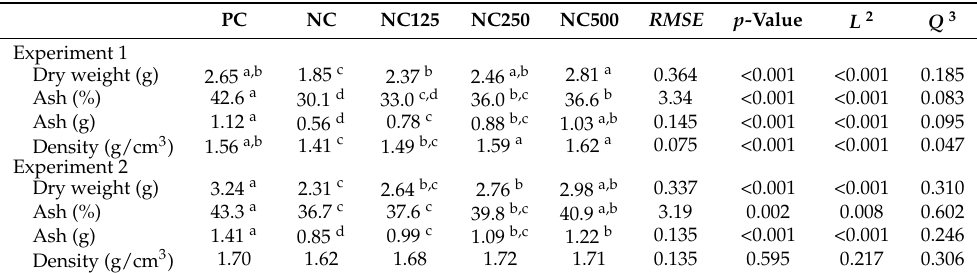
Table 4. Effect of 6-phytase supplementation to negative control diets on bone mineralization (left Os metacarpale III ) and density (left Os metacarpale IV ) 1